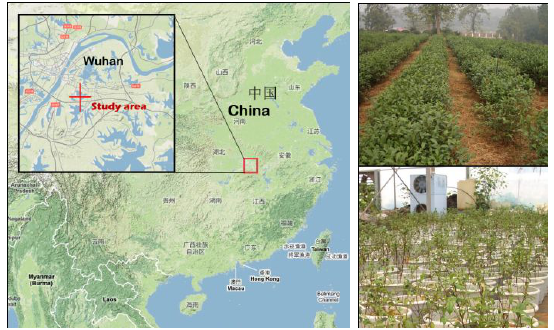
Figure 1. Location of the Huazhong Agriculture University, Wuhan, China (left part of the figure). The right part shows the pictures of the tea garden (top) and the greenhouse setup before fertilization (bottom) in the university.